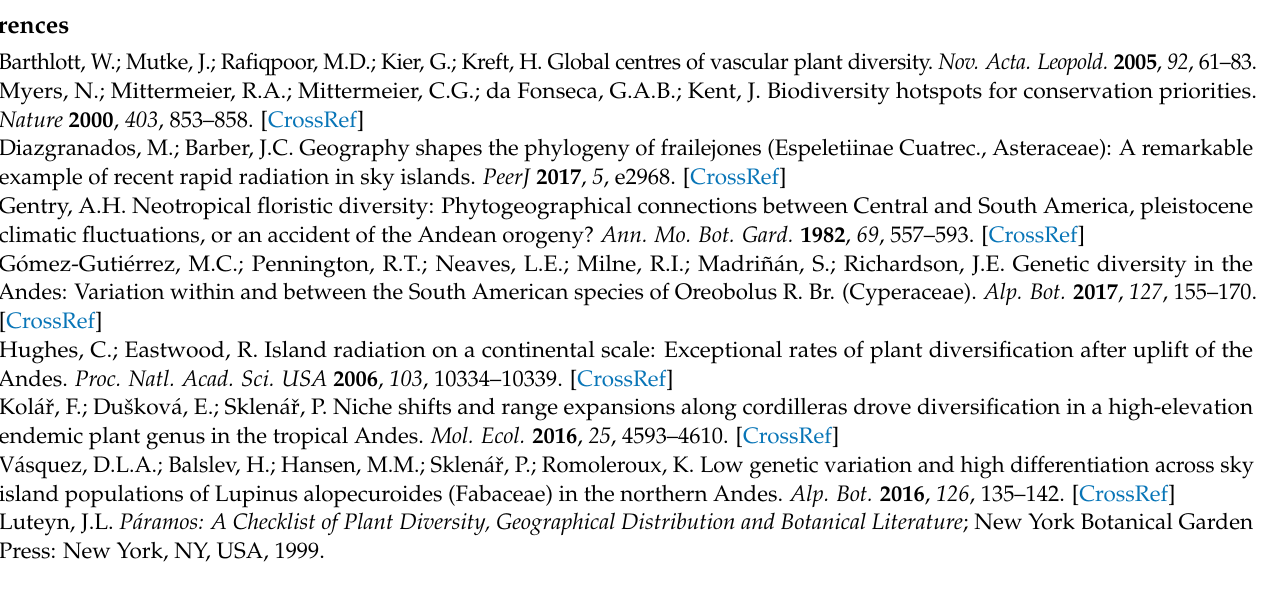
Figure S3: Non-metric multidimensional scaling (NMDS) showing the correlation between the metabolic fingerprints of 109 taxa of Colombian (A) and Venezuelan (B) Espeletiinae, Figure S4: PCA scores plot resulting from the analysis of negative ion mode dataset with variables transformed to binary values, Figure S5: Decision-tree resulting from the analysis of negative ion mode dataset with variables transformed to binary values, Table S1: Detailed mass spectrometry information of all dereplicated metabolites in species of Espeletiinae, Table S2: Names, codes, geographical origin and environmental variables associated with the investigated samples of Espeletiinae, Table S3: Names, codes, and geographical origin of the samples of Espeletia investigated in the intraspecific dataset, Table S4: Model statistics for the interspecific and intraspecific